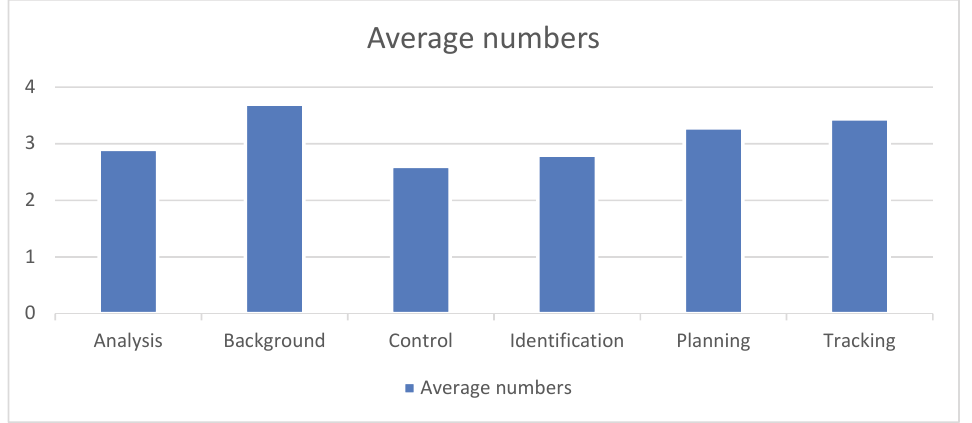
Fig. 1. The average numbers for each